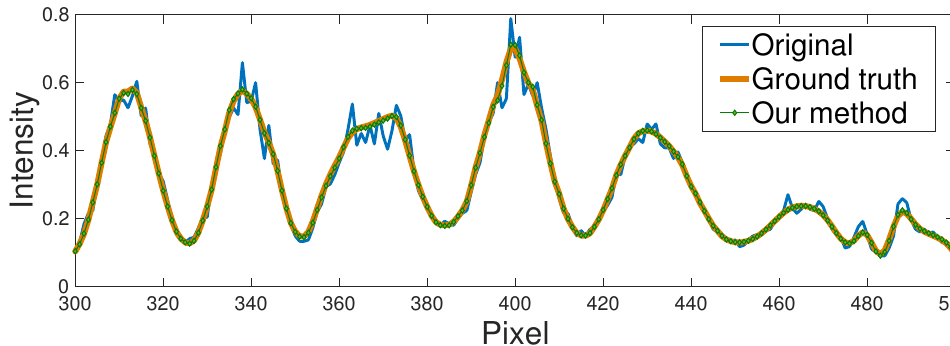
Figure 6. The comparison of the algorithm in the 300th row from Figure 5a3,b3,c3. Table 1. Comparison of image denoising processing time between BM3D and our deep learning-based method for different scenes. Time Cost of Fringe Analysis BM3D/s Our Method/s Scene 1 1.983